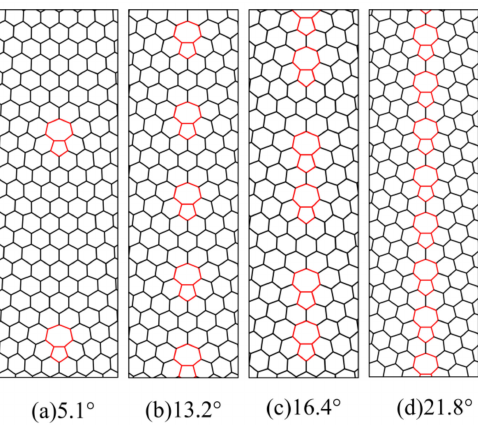
Figure 2. Schematic of the zigzag-oriented grain boundary (GB) models with different misorientation angles.